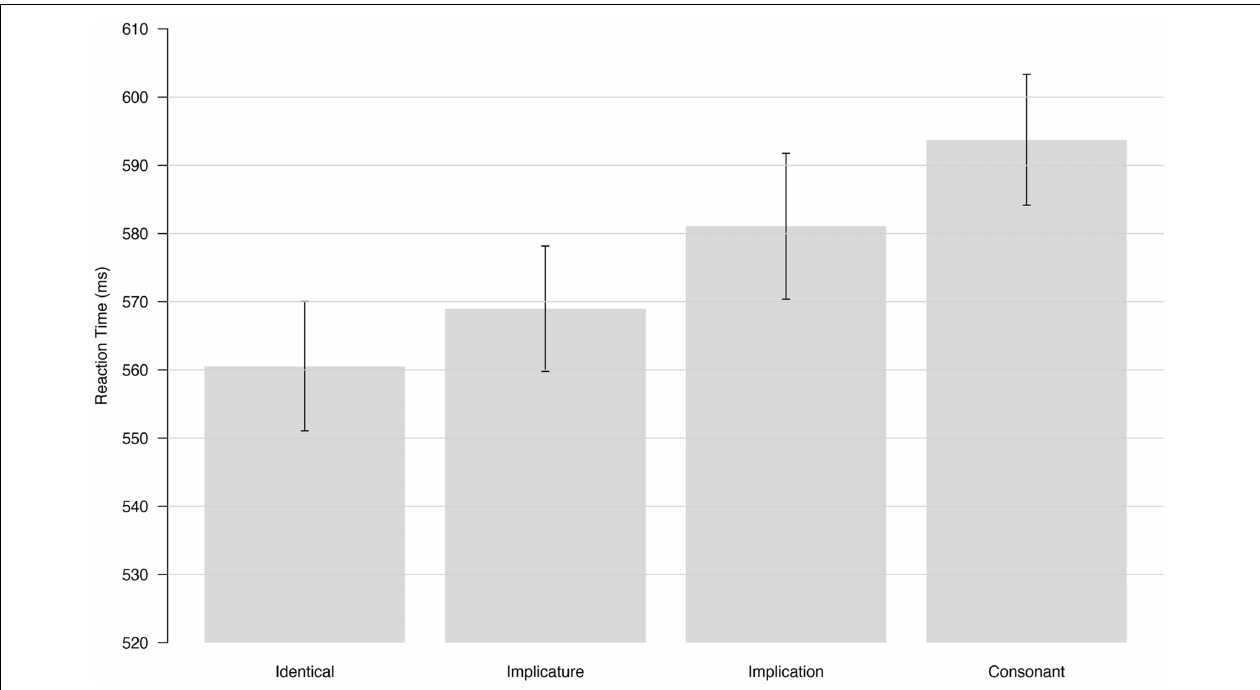
FIGURE 2 | Grand Average of Reaction Time (RT; ms) obtained for each condition. Error bars represent the standard error of the mean across 48 subjects.